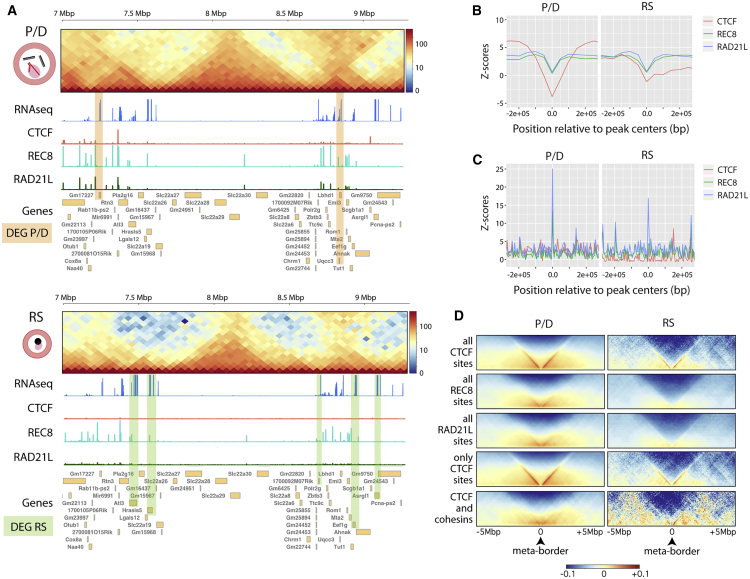
Local Insulation, Cohesin Occupancy, and Gene Expression(A) Representative examples of CTCF and cohesins’ genomic distributions across a specific region of chromosome 19 (from 7 to 9.3 Mbp) in P/D and RSs. For each cell type, Hi-C interaction maps (50-Kbp bins), gene expression (represented as log FPKM), CTCF peaks, cohesin peaks, and genes from NCBI Ref Seq annotation are displayed. Green and orange highlights indicate differentially expressed genes (DEGs) in each cell type: Gm17227 and Uqcc3 for P/D and Atl3; Hrasls5, 1700092M07Rik, Eef1g, and Asrgl1 for RSs.(B) Distribution of CTCF and cohesin peaks at TAD borders. The y axes represent the TAD insulation Z-score relative to random genomic regions (based on 10,000 permutation tests with randomization, p < 0.01).(C) Distribution of gene expression for CTCF and cohesin peaks located at TAD borders. The y axes represent the TAD insulation Z-score relative to random genomic regions (based on 10,000 permutation tests with randomization, p < 0.01).(D) Meta-plots for all peaks detected in P/D and RSs.P/D, pachynema-diplonema; RS, round spermatids. See also Figure S6.